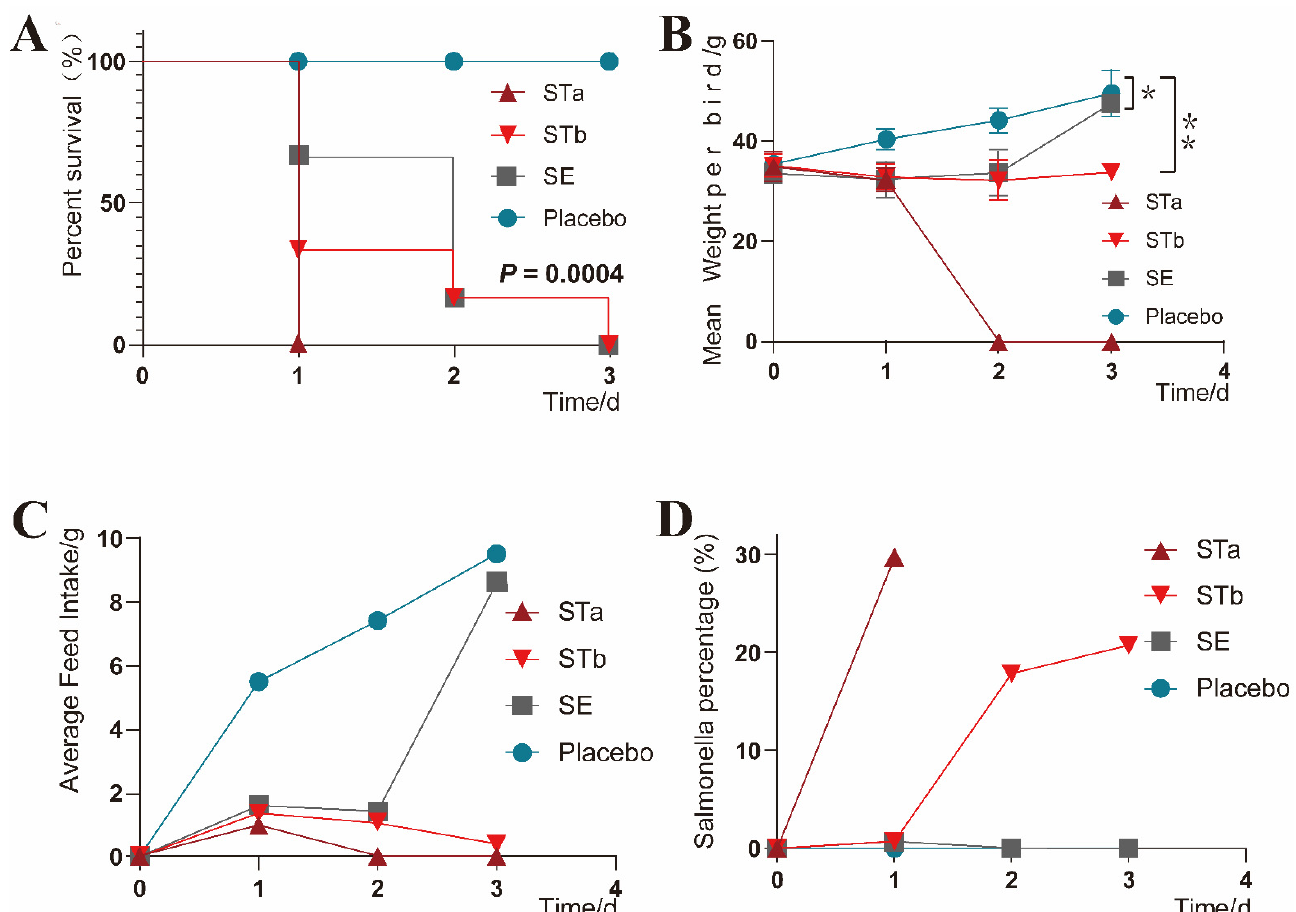
Figure 4. Quantitative analysis of physiological indices before and after experimental inoculation. ( A ) Survival curve plots of four sets of SPF chick experiments during 3 days (log-rank test, p = 0.0004). ( B ) Mean daily weight curves of each bird of each group during 3 days (Mean ± SD, MANOVA of repeated measures, p < 0.05, p 1 = 0.0313, p 2 = 0.0037). * p < 0.05 ** p < 0.01 ( C ) The curves of average daily feed intake of each group. ( D ) Daily changes in the proportion of Salmonella in